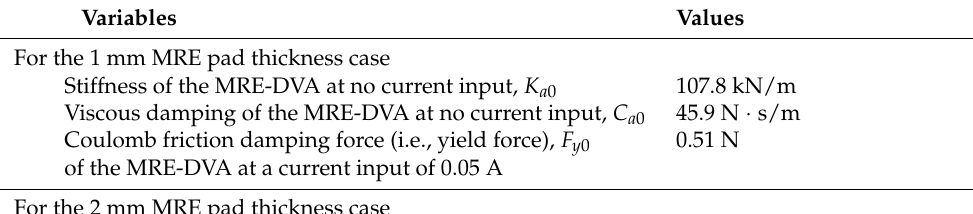
Table A1. The identified system parameters for the MRE-DVAs with the 1 mm, 2 mm and 3 mm MRE pad